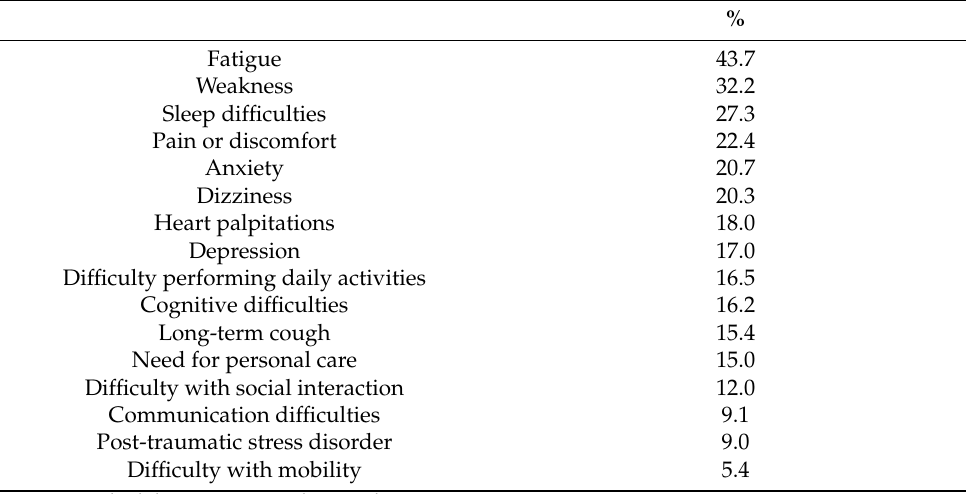
Table 3. Frequency of long-term symptoms (N = 170).